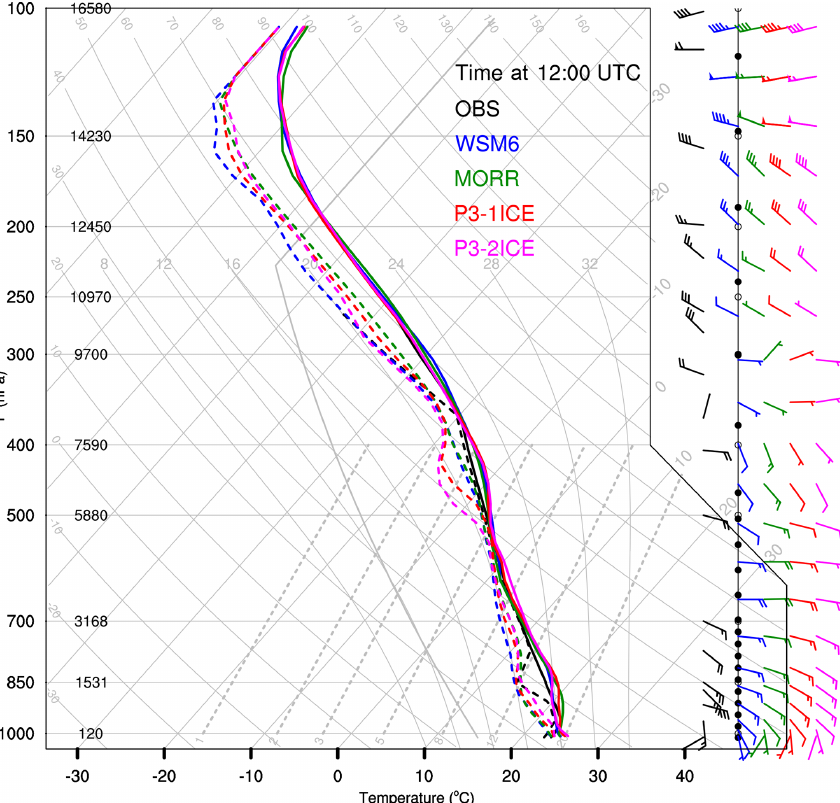
Figure 3. Skew-T plot of observed and simulated Cayenne radiosonde data at 12:00UTC on 26 May 2015. One full wind barb represents 10 knots ( ∼ 5 . 14ms − 1 ). The location where Cayenne radiosonde was released is shown in Fig.